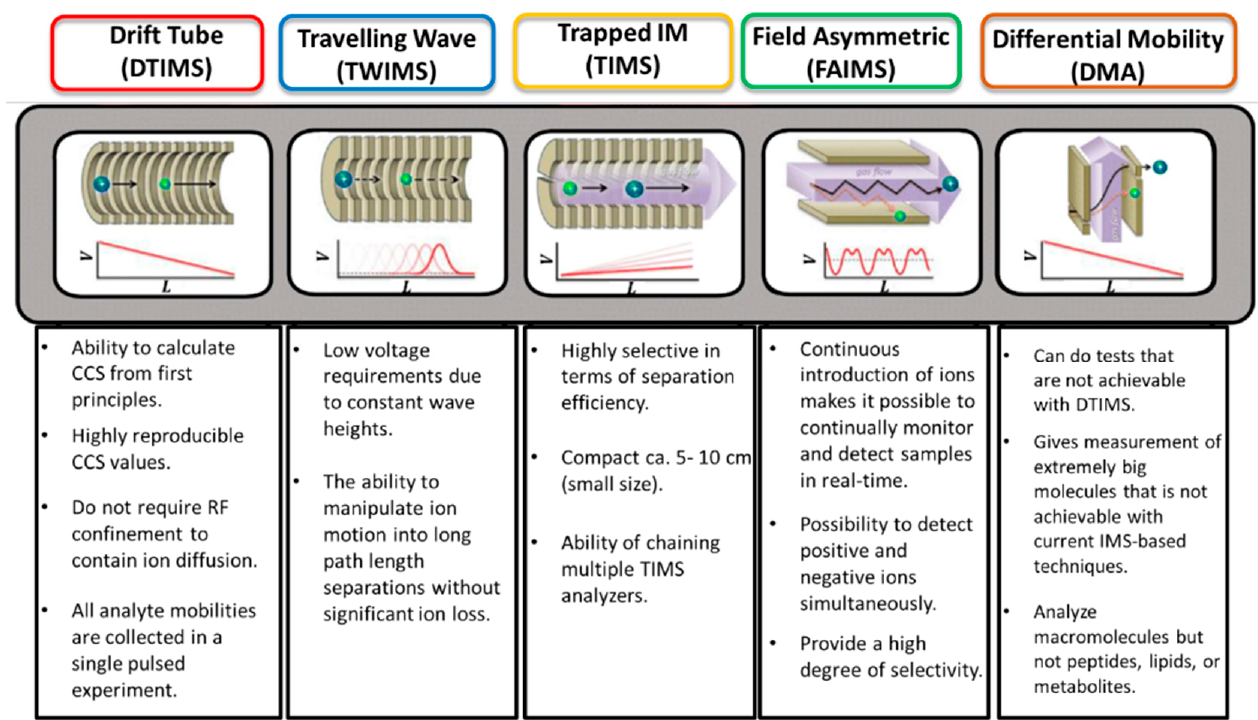
Figure 8. Advantages of the different of IMS technology [108,121–123]. Instrument diagram reprinted with permission from Ref. [123]. 2011, Elsevier .